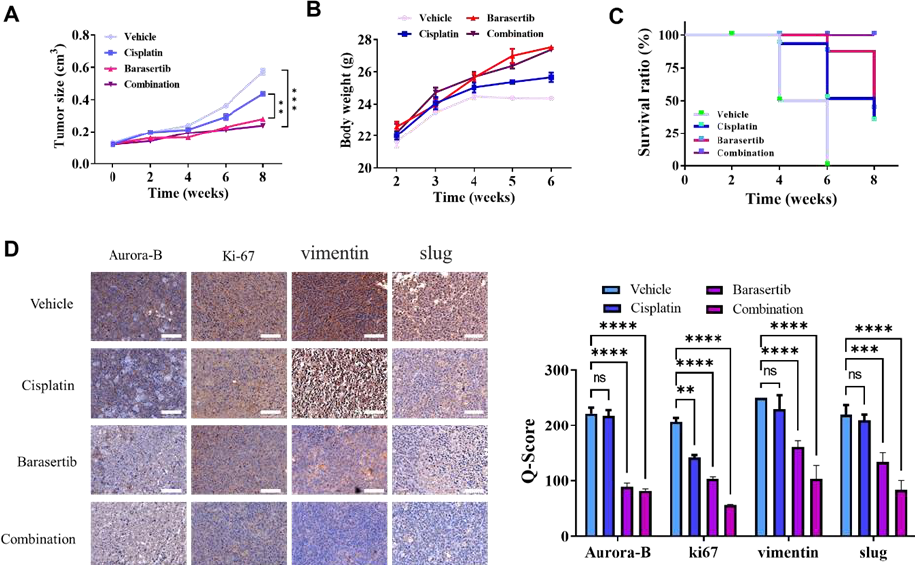
Figure 7. Cisplatin and barasertib co-treatment extend tumor suppression potential in vivo. ( A ) Treatment with a combination of cisplatin and barasertib significantly reduced the growth of HNSCC tumors compared with monotherapy or vehicle treatment. ( B ) Body weight did not significantly differ between the combination treatment, monotherapy, and vehicle treatment groups. ( C ) Mice in the combination group exhibited longer survival than did those in the monotherapy or vehicle group, suggesting the superior efficacy of the combination treatment in HNSCC. ( D ) Tissue staining revealed a significant reduction in cellular proliferation, aggressiveness, and epithelial-to-mesenchymal transition potential, as indicated by decreased levels of Ki67, Vimentin, and slug, respectively. Significance level: ns: not significant; ** p < 0.01; *** p < 0.001; **** p < 0.0001. Scale bar: 200 μm.